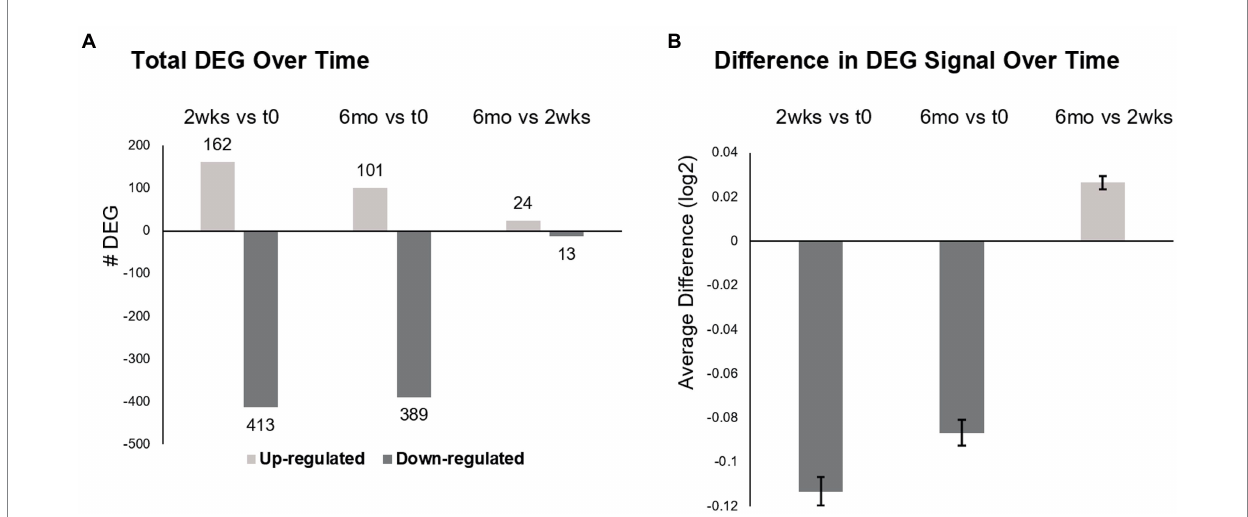
FIGURE 2 Differentially expressed genes (DEG) in MS PBMC at time 0, 2 weeks, and 6 months after ocrelizumab infusion. (A) Total number of DEG at 2 weeks post-ocrelizumab infusion vs. time 0 after 2-month prior therapy washout (575 DEG), at 6 months vs. time 0 (490 DEG), and at 6 months vs. 2 weeks (37 DEG). (B) The average difference in gene expression increases at 6 months vs. 2 weeks. Significance between these large numbers of DEG is high; for 0.5 vs. 0, p = 7 × 10 − 67 ; 6 vs. 0, p = 7 × 10 − 49 ; 0.5 vs. 6, p = 9 × 10 − 18 , two-tailed paired t -test. (A,B) Based on 9,406 genes with Time F -Test <0.05, log2 scale. See text for calculations. Bars show mean ±